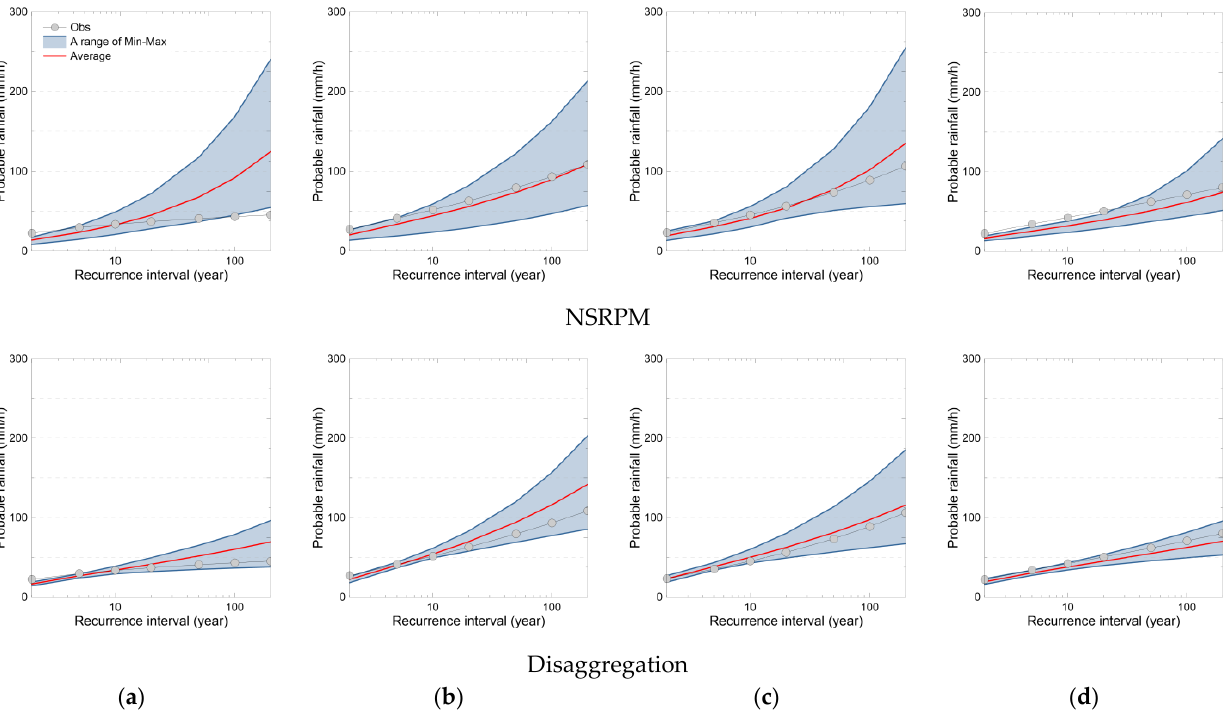
Figure 9. Comparison of T-year rainfall quantile based on the downscaled 1 h rainfall from the NSRPM and RTD-NSRPM methods for the present period. ( a ) Ulsan, ( b ) Busan, ( c ) Changwon, and ( d ) Miryang.